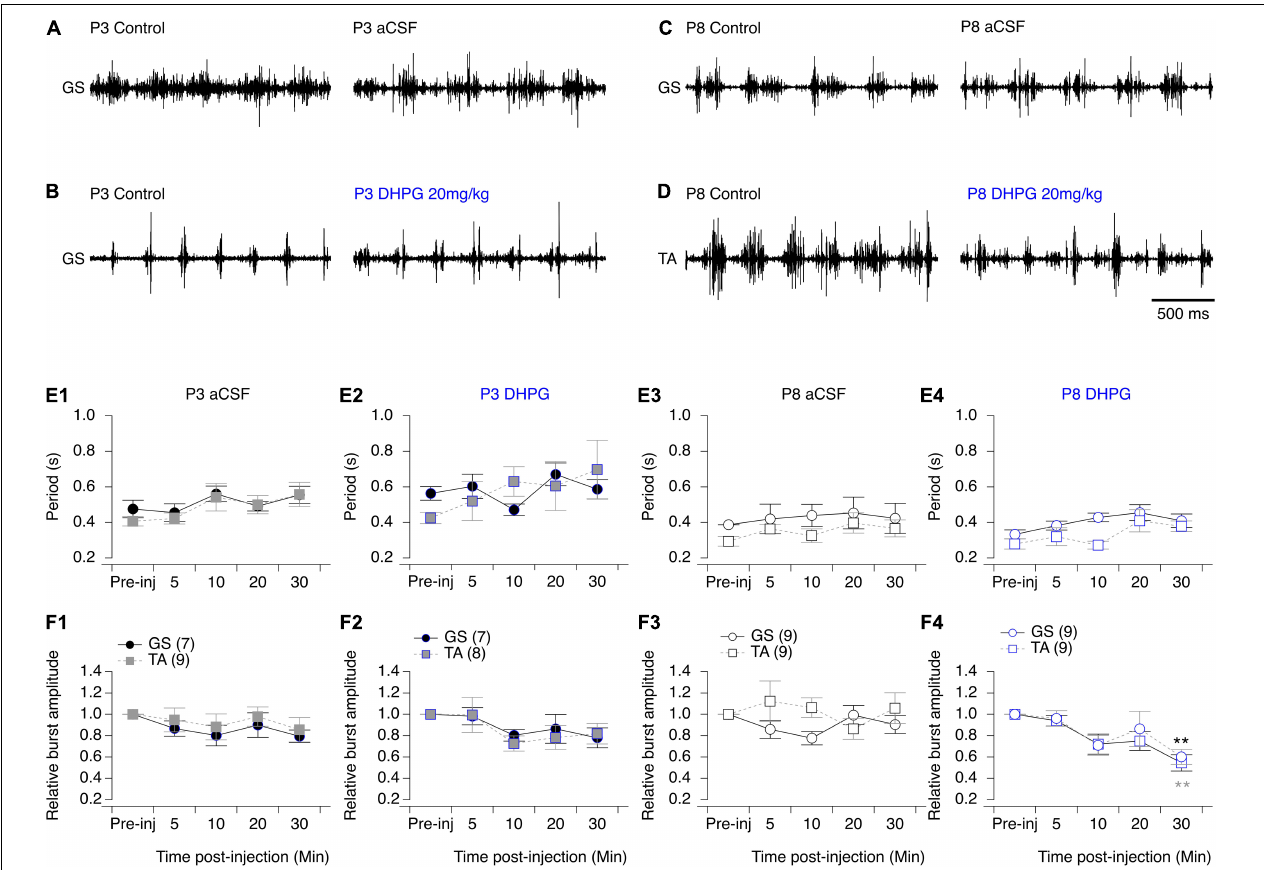
FIGURE 8 | Effects of aCSF and mGluRI agonist on spontaneous swimming activity in mice. (A–D) Representative electromyographic recordings from a hindlimb Gastrocnemius (GS) or Tibialis Anterior (TA) muscle before (control) and 30 min after the injection of aCSF (A,C) or DHPG (B,D) in P3 (A,B) and P8-P10 (C,D) mice. (E) . Cycle period of the swimming activity recorded from the GS (black circles) or TA (gray squares) before (pre-inj) and at different time points (5, 10, 20, and 30 min) after the injection of aCSF (E1–E3) or DHPG (E2–E4) . (F) Same data representations as in (E) for swimming burst amplitudes normalized to mean amplitude values. DHPG induced a significant decrease in the period of the swimming activity in P8 mouse pups. Numbers in brackets correspond to the number of animals tested. Two-way RM ANOVA followed by Sidak’s post hoc tests. ** p < 0.01 significantly different from the pre-injection burst amplitude.